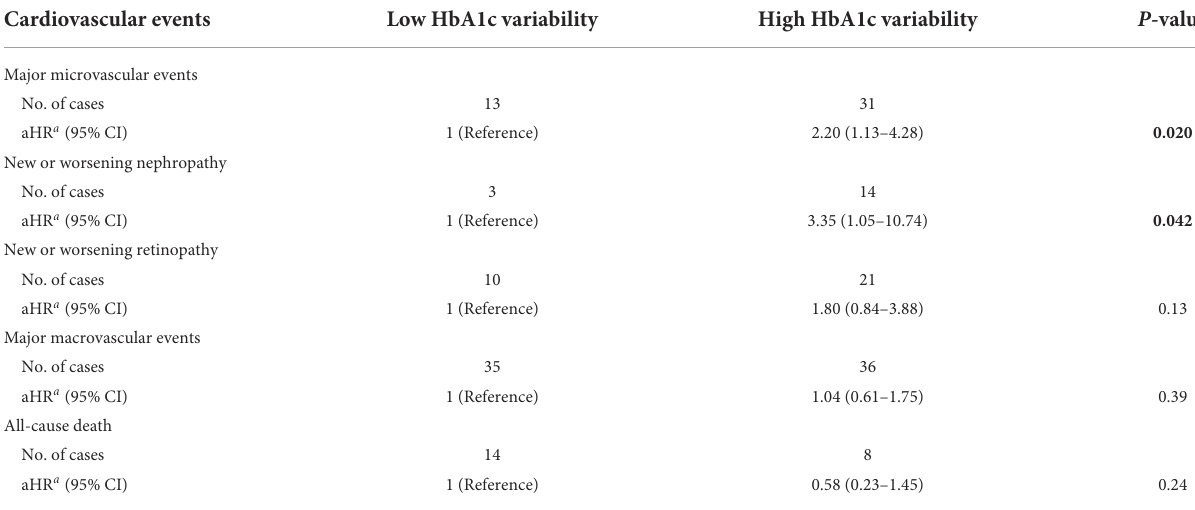
TABLE 3 The risk of cardiovascular events according to visit-to-visit HbA1c variability in patients of WTH group. Cardiovascular events